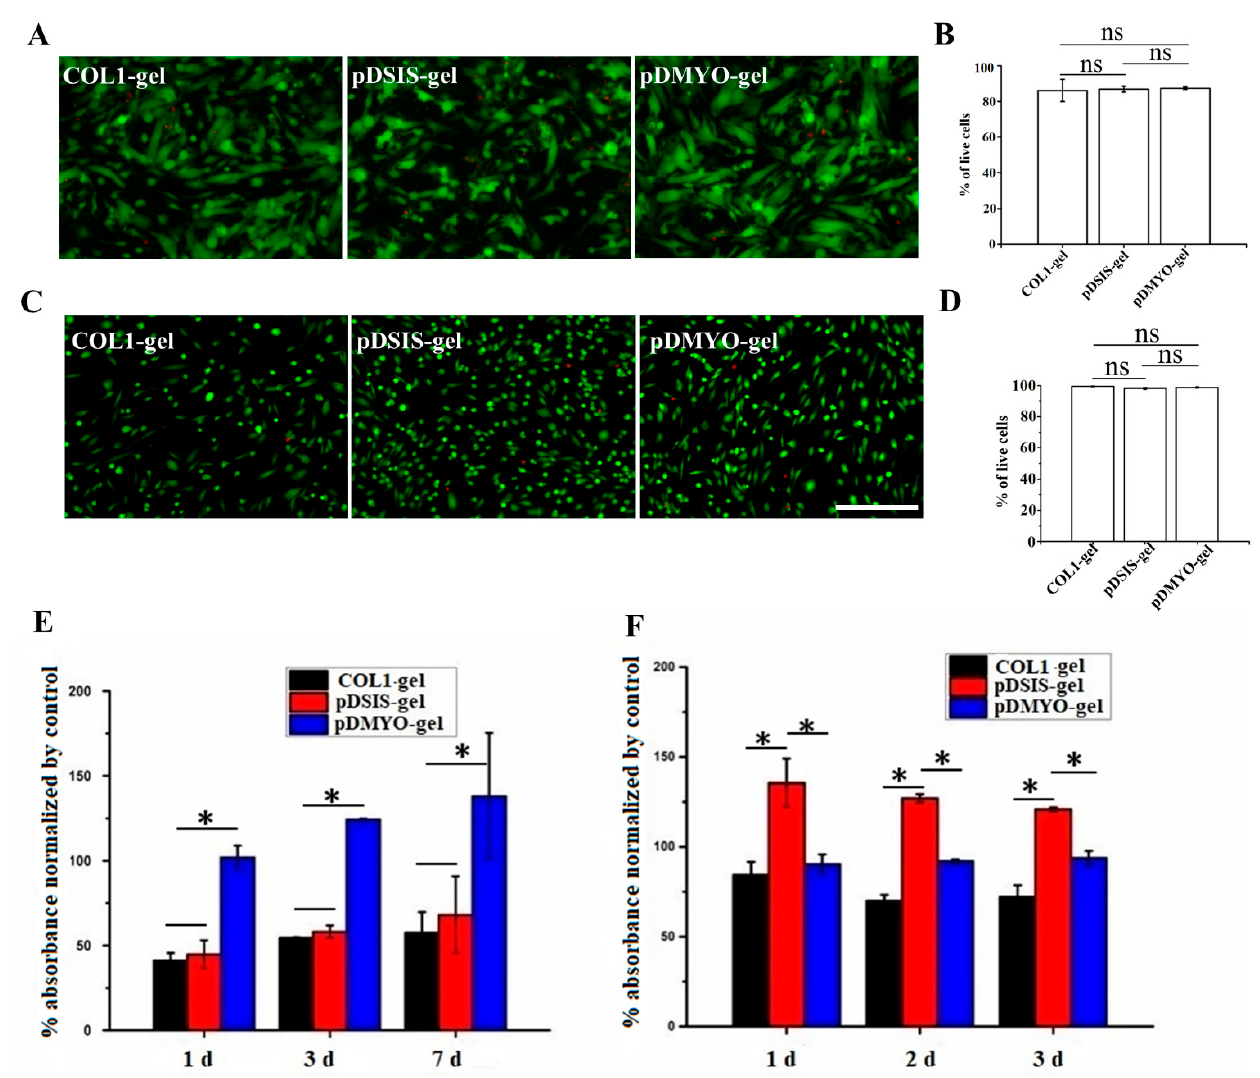
Figure 2. Assessment of the biocompatibility and capacity to sustain cell viability of the porcine decellularized matrix gels and collagen gels on myocardial-related cells. ( A ) Live/Dead staining of cardiomyocytes cultured on three different hydrogels after three days; scale bar = 500 µ m; ( B ) Survival rate of cardiomyocytes cultured on three different hydrogels; ( C ) Live/Dead staining of human umbilical vein endothelial cells cultures on three different hydrogels; scale bar = 500 µ m; ( D ) Survival rate of human umbilical vein endothelial cells on three different hydrogels; ( E ) Effect of three different hydrogels on cardiomyocytes viability; ( F ) Effect of three different hydrogels on human umbilical vein endothelial cell viability. * denotes statistical difference within the same group with p < 0.05, respectively ( n > 3).